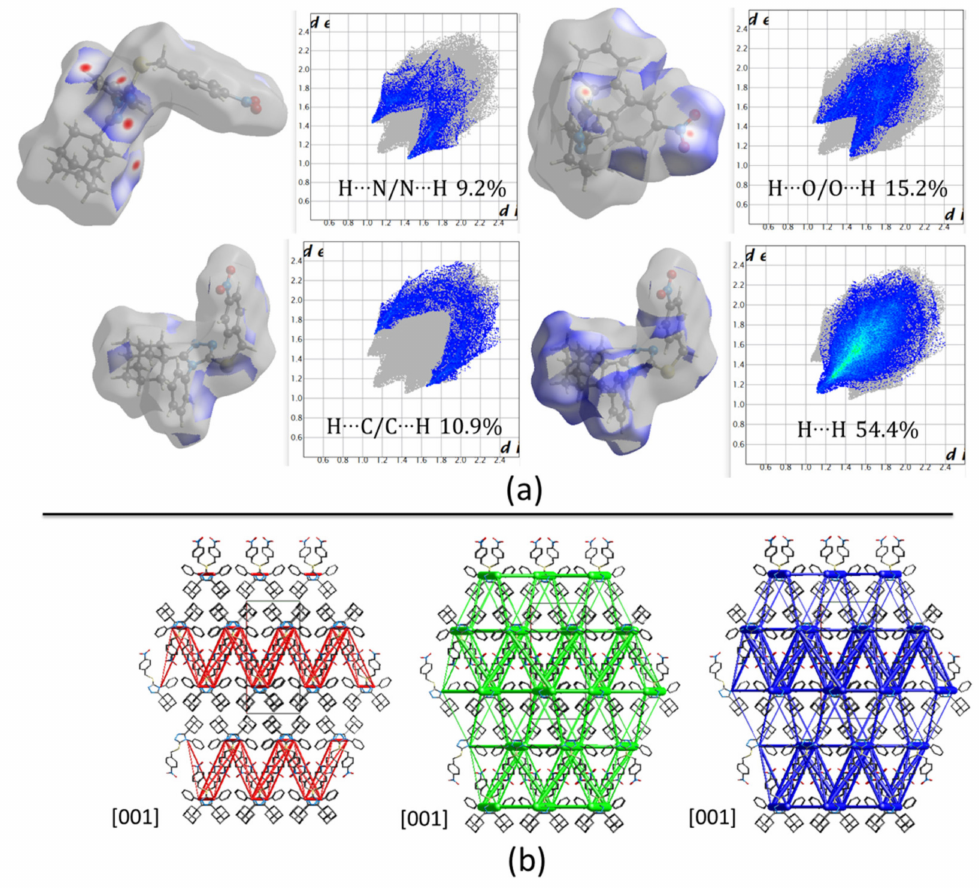
Figure 5. ( a ) Hirshfeld surfaces mapped over d norm and the two-dimensional fingerprint plots, ( b ) Energy framework diagrams for electrostatic (red) and dispersion (green) contributions to the total interaction energies (blue) in compound 1